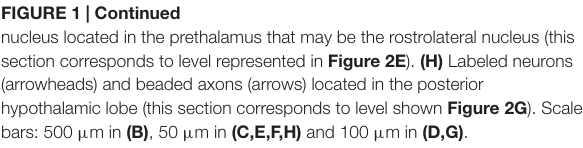
Frontiers in Neural Circuits |